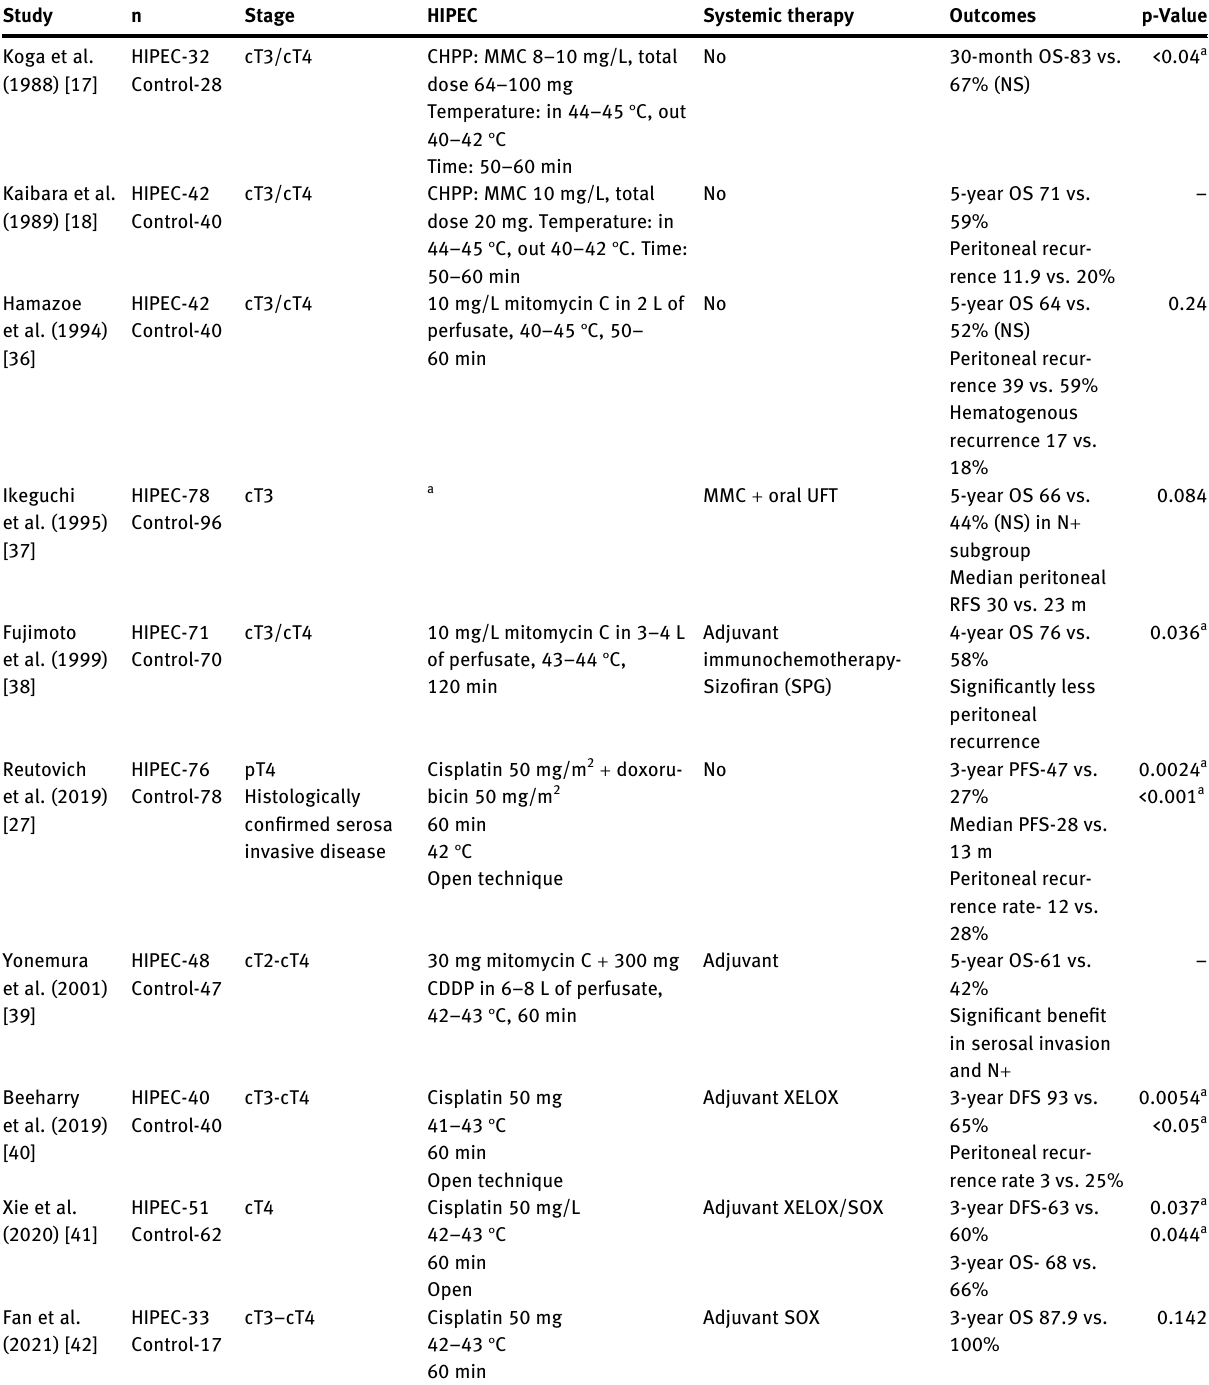
Table  : Randomized controlled trials for p-HIPEC.